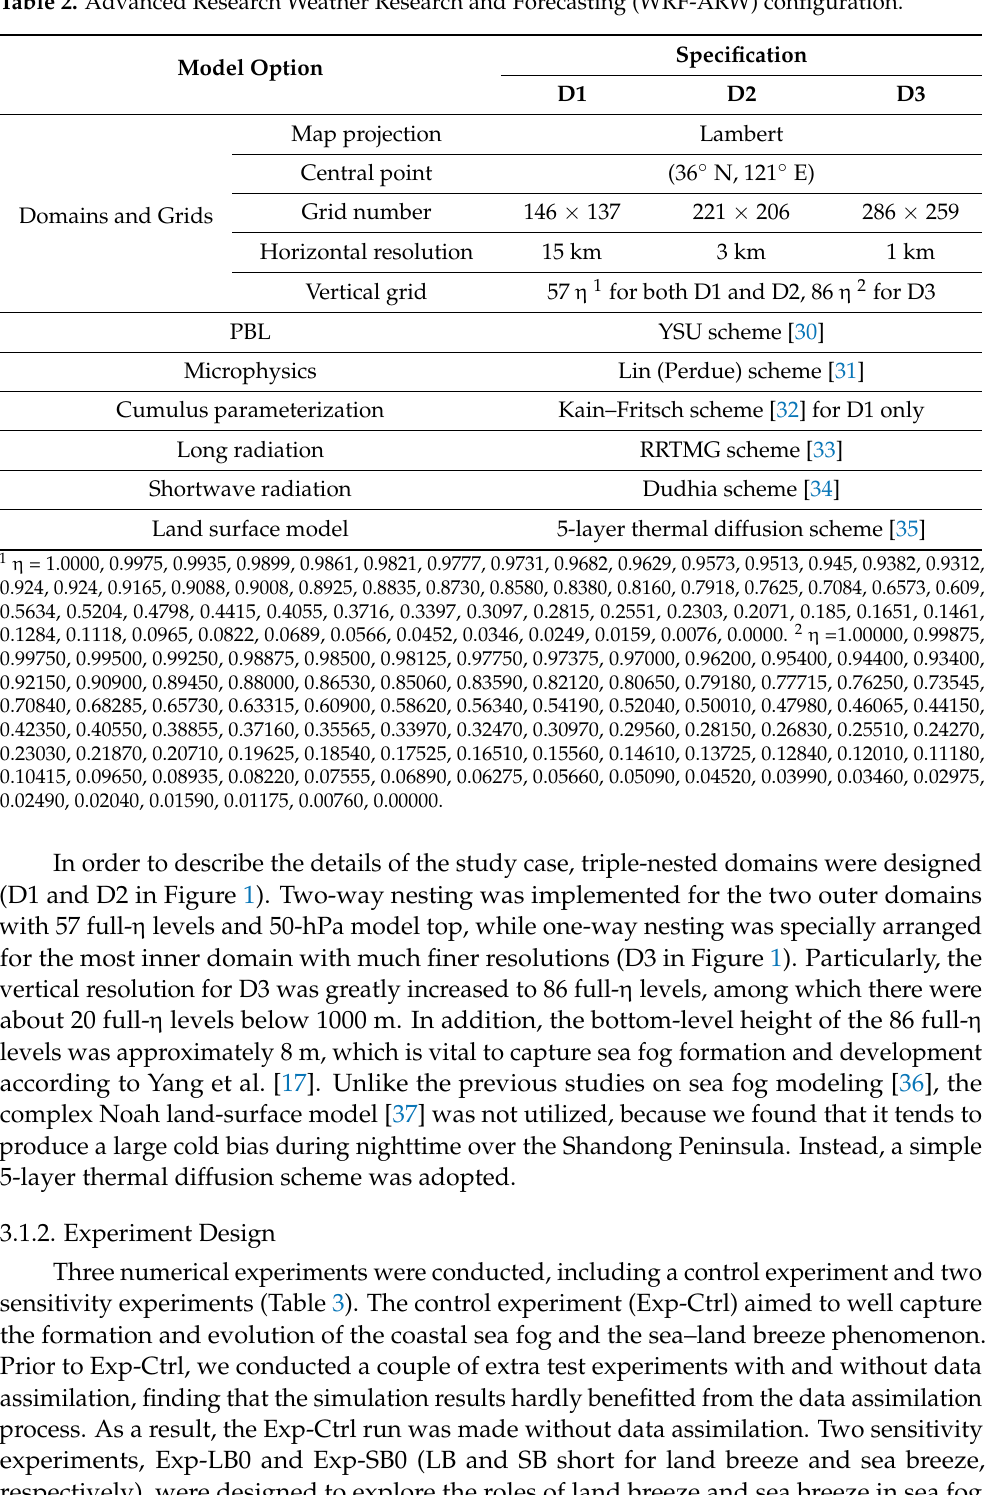
Table 2. Advanced Research Weather Research and Forecasting (WRF-ARW)